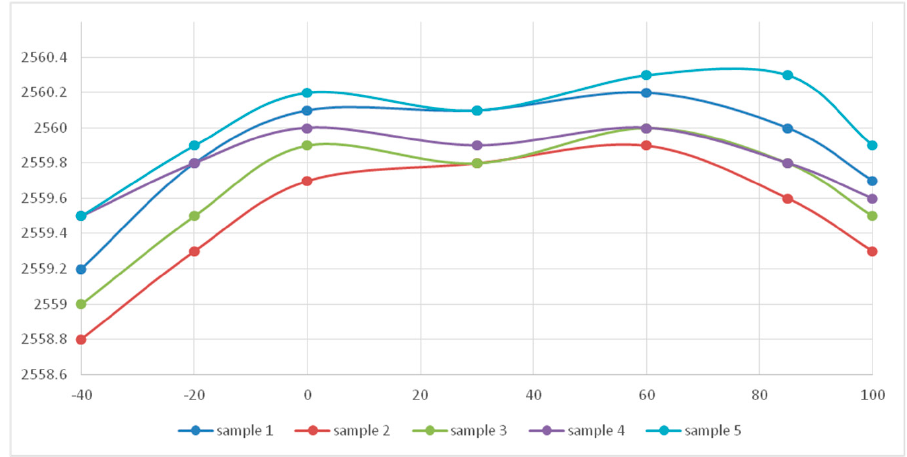
Figure 14. Five random samples measurement results.